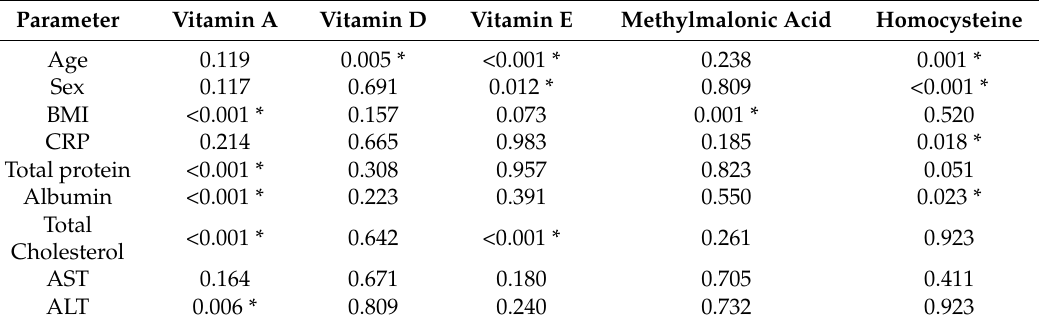
Supplementary Table 1. Factors associated with vitamin concentrations: p -values for multivariable